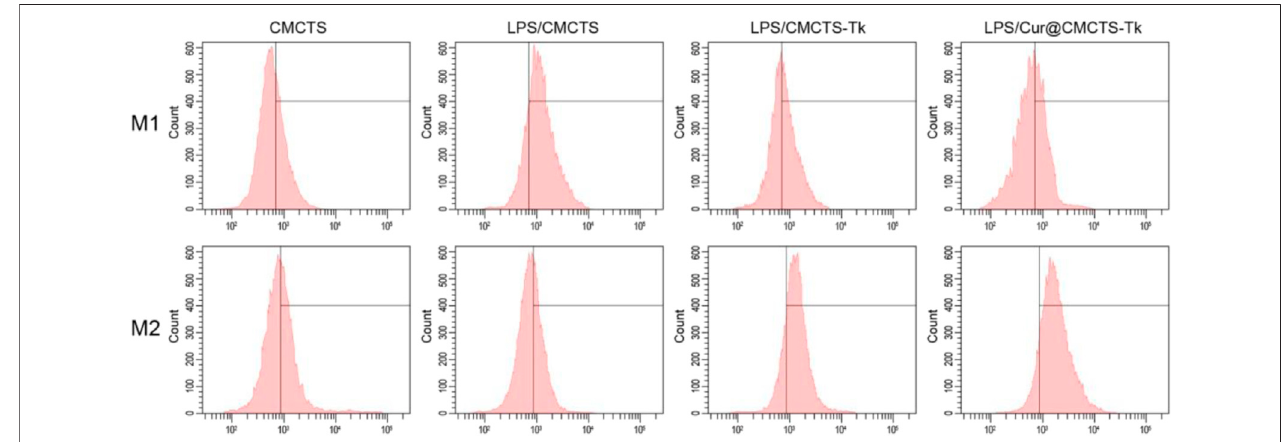
FIGURE 5 | FCM results of RAW cells cultured with normal CMCTS hydrogel (control) and LPS/CMCTS (LPS), LPS/CMCTS-Tk, and LPS/Cur@CMCTS-Tk hydrogel after 24 h. RAW cells were stained with M1 marker CD86 and M2 marker CD206. The ratios of M1 and M2 phenotypes of macrophages were also presented.